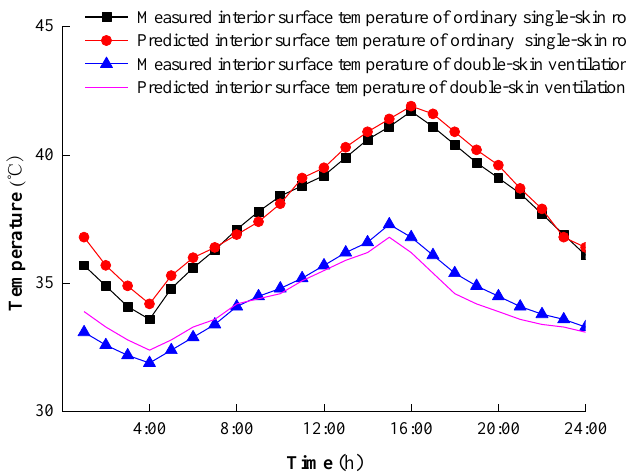
Figure 4. Measured and predicted inner surface temperature of roofs.